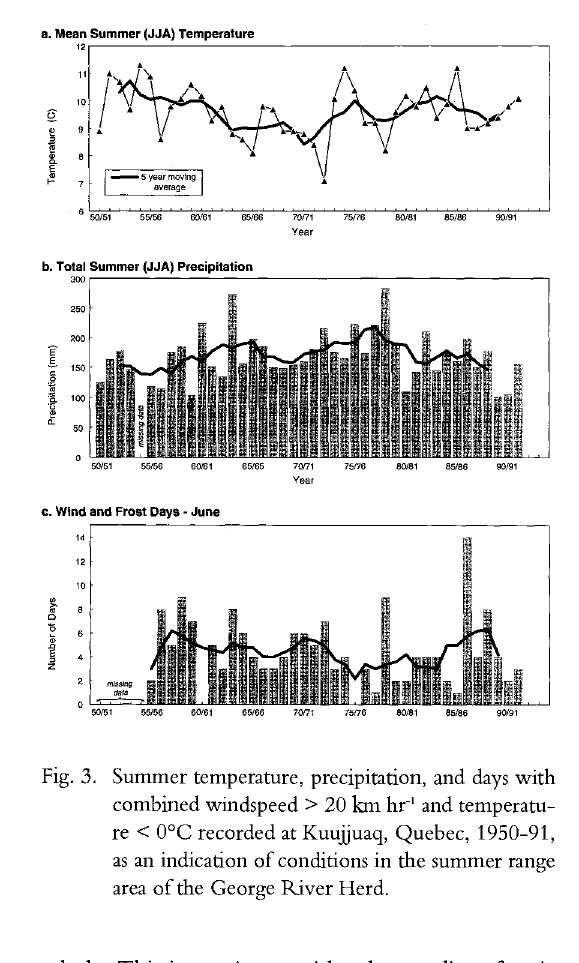
Fig. 3. Summer temperature, precipitation, and days with combined windspeed > 20 km hr" 1 and temperatu re < 0°C recorded at Kuujjuaq, Quebec, 1950-91, as an indication of conditions in the summer range area of the George River